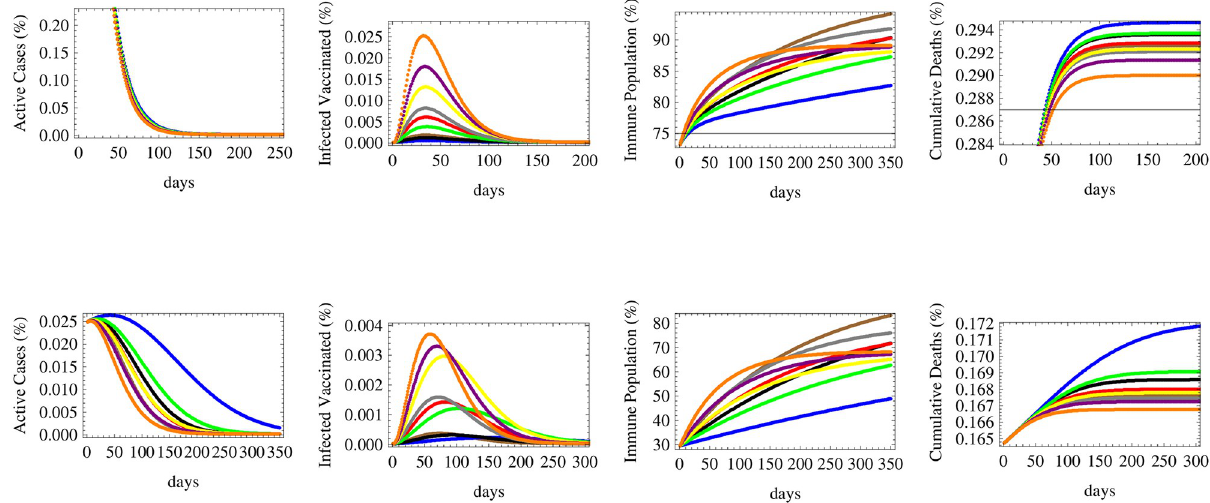
Fig 4. The figure shows the relative numbers of active cases, infected vaccinated cases, immune population and total cumulative deaths for a high reproductive rate R = 1.5 with the same two initial conditions and nine vaccination scenarios of Fig 2.